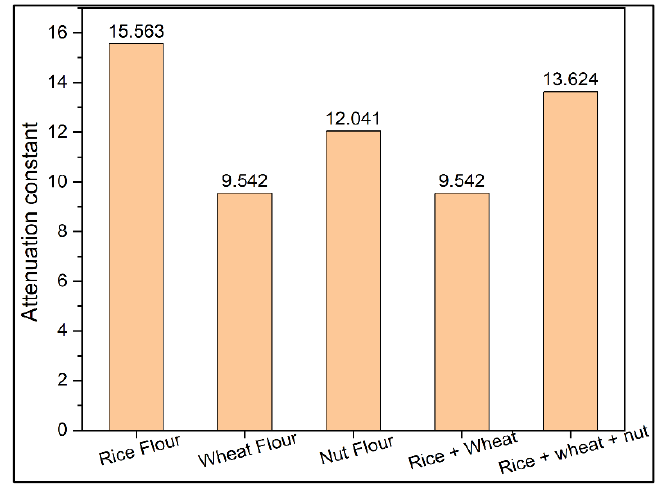
Figure 3. Attenuation of rice flour, wheat flour, nut flour and their mixtures.